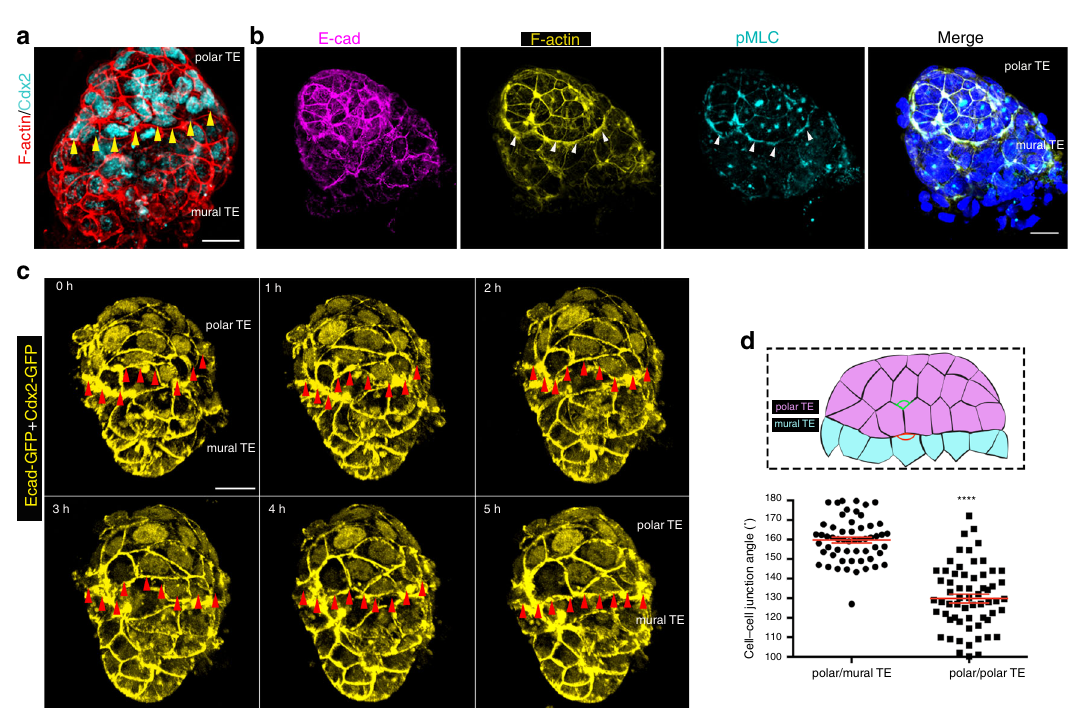
Fig. 2 Establishment of tissue boundary within the trophectoderm. a Maximum intensity projection (MIP) image of an implanted E4.75 blastocyst. Arrowheads indicate tissue boundary between polar and mural TE. Representative example of 20 embryos. b MIP image of an implanted E4.75 blastocyst. Arrowheads indicate actomyosin enrichment at the boundary between polar and mural TE. Representative example of eight embryos. c Stills from a time lapse movie of Cdx2/E-Cad GFP E4.5-implanting blastocyst. Red line follows the boundary between high-Cdx2 cells (polar TE) and low-Cdx2 cells (mural TE). As development progresses, polar and mural TE cells segregate and a linear tissue boundary formed (arrowheads). d Quanti fi cation of cell – cell junction angle at the polar/mural TE boundary and within polar TE. Two-sided unpaired student ’ s t test; **** P < 0.0001; mean ± SEM. n = 56 polar/mural TE and 63 polar TE cell junctions. Source data are provided as a Source Data fi le. Scale bars = 20 µ m